Question: Is the quantity shown trending increasing or decreasing?
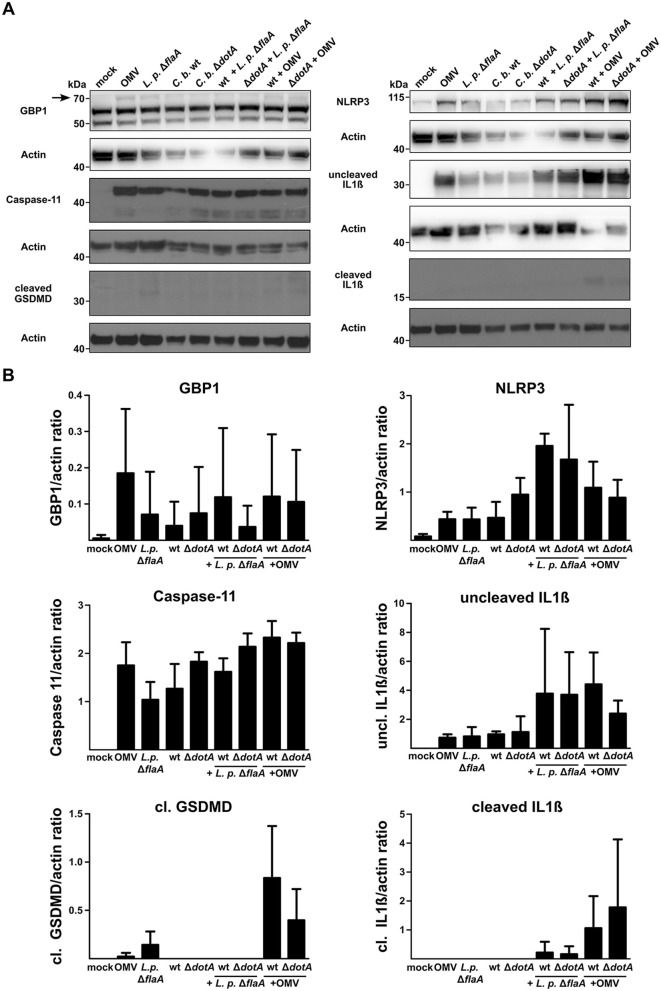
Answer: increasing